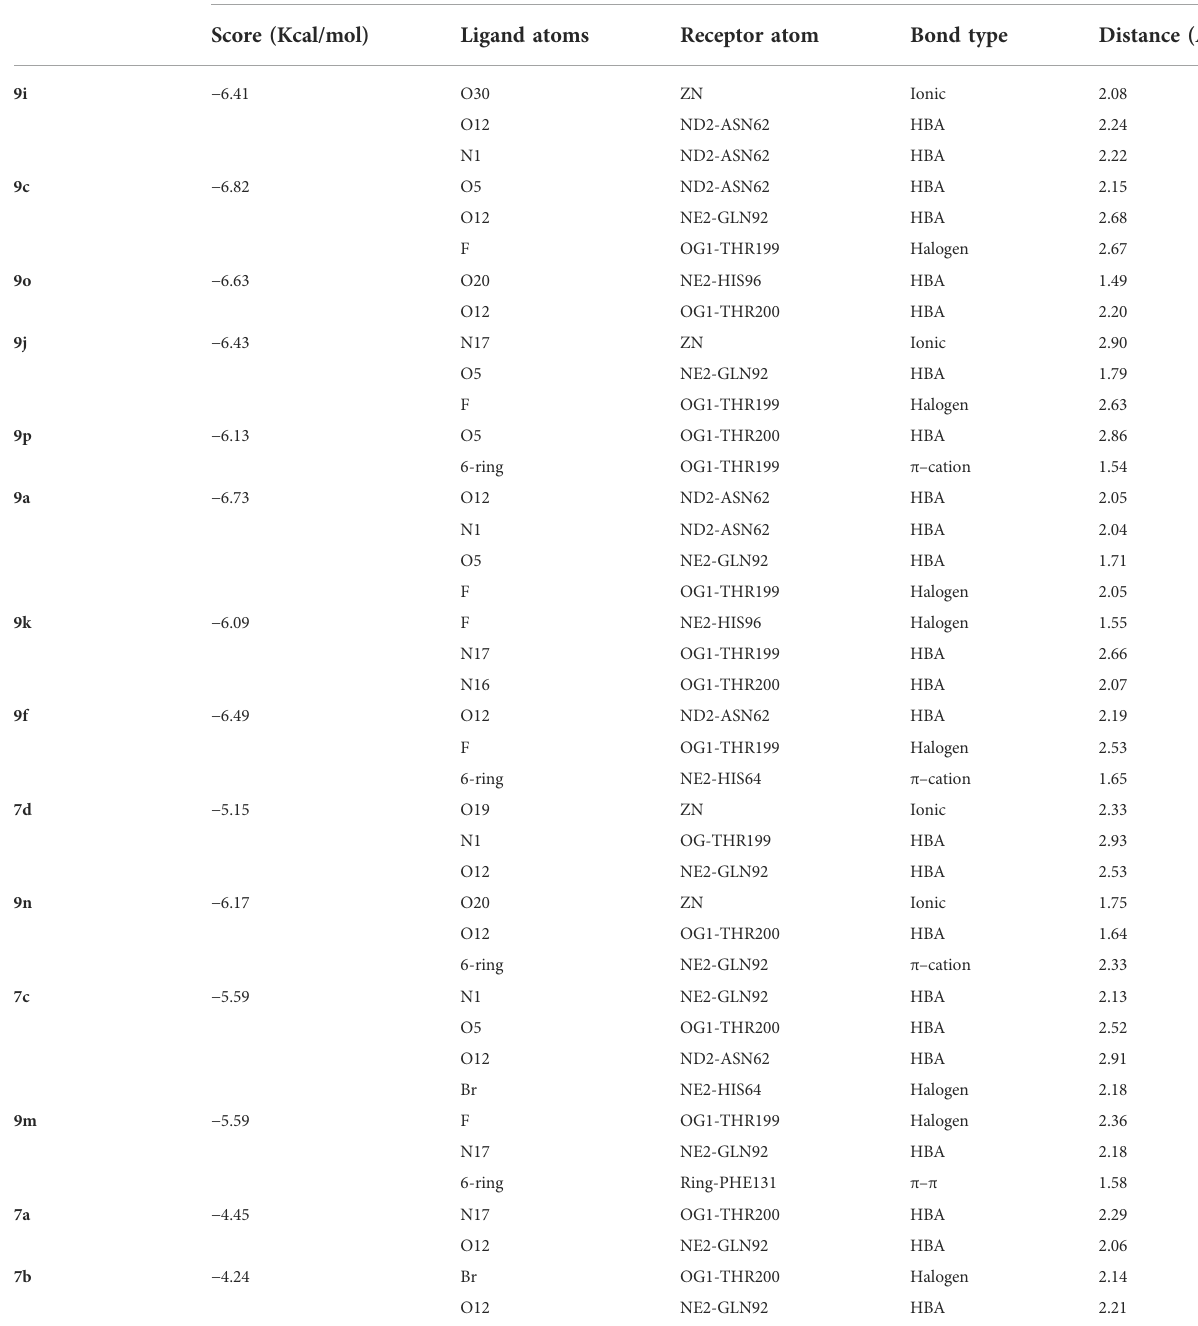
TABLE 5 Binding analysis of 1H-1,2,3-triazole analogues in the active site of hCA-II.